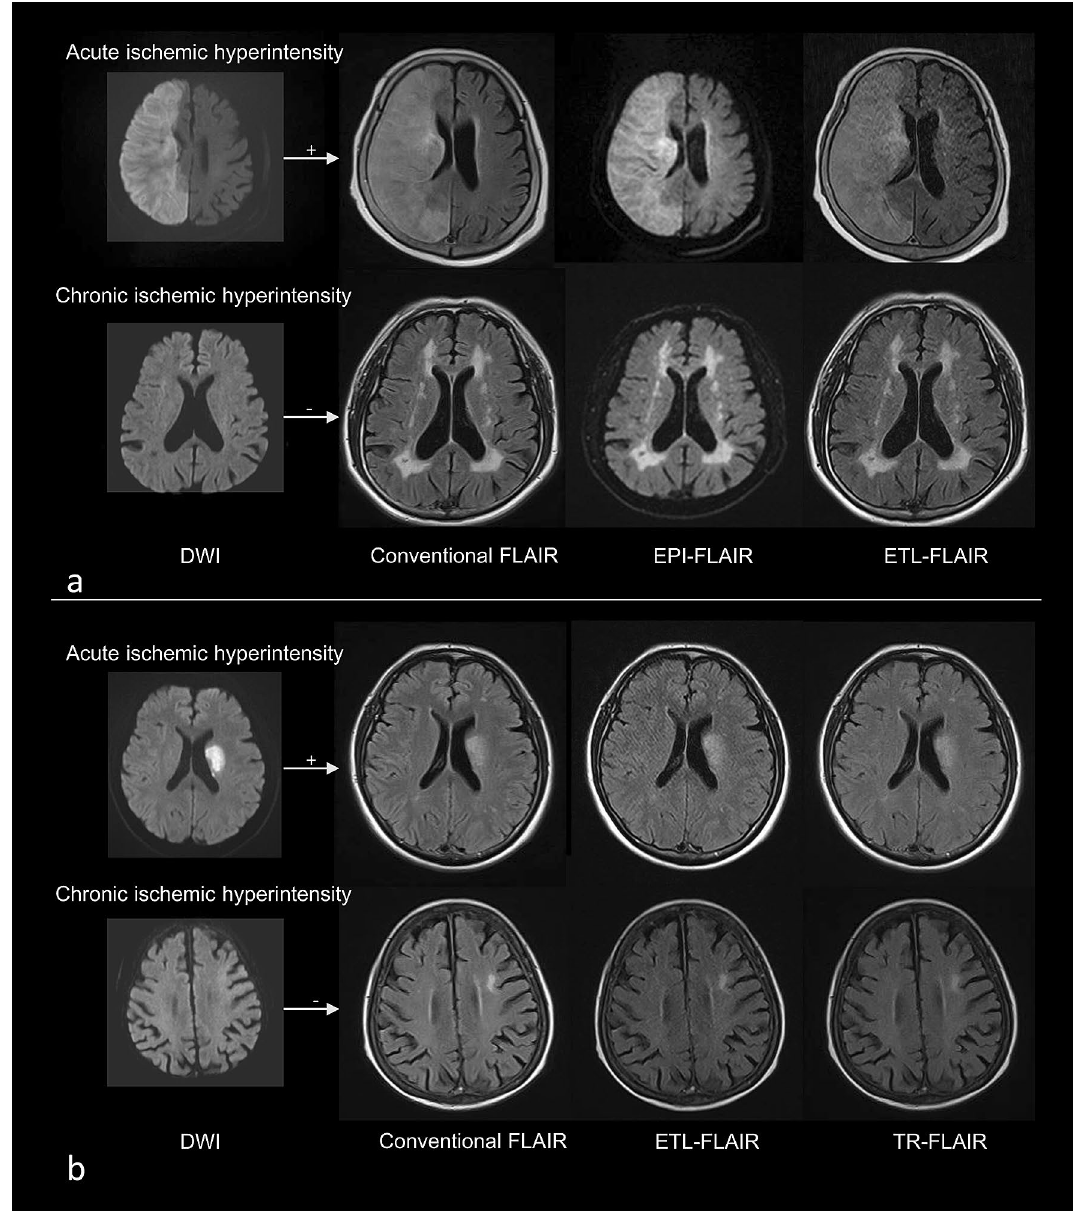
Figure 4. Acute and chronic ischemic hyperintensities on conventional T2-FLAIR and fast scanned T2-FLAIR with respect to DWI. (a) First group with conventional T2-FLAIR, EPI-T2-FLAIR, and ETL-T2-FLAIR. (b) Second group with conventional T2-FLAIR, ETL-T2-FLAIR and TR-T2-FLAIR. DWI diffusion-weighted image, FLAIR fluid attenuated inversion recovery, EPI echo-planar imaging, ETL echo train length, TR repetition